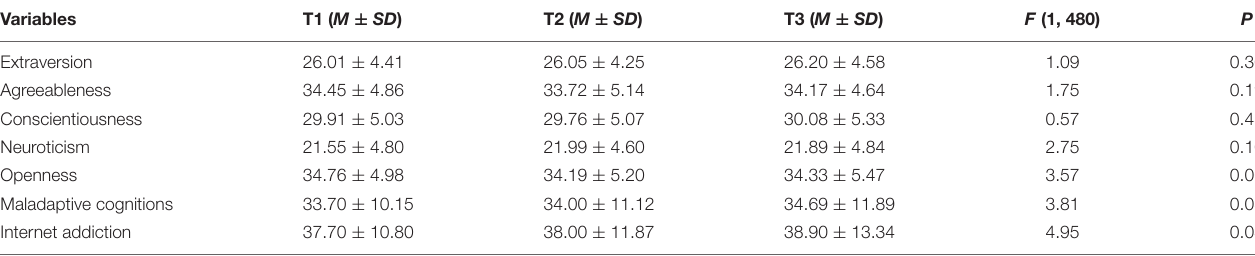
TABLE 2 | Pairwise comparisons of the Big Five personality traits, maladaptive cognitions, and Internet addiction across time. Variables